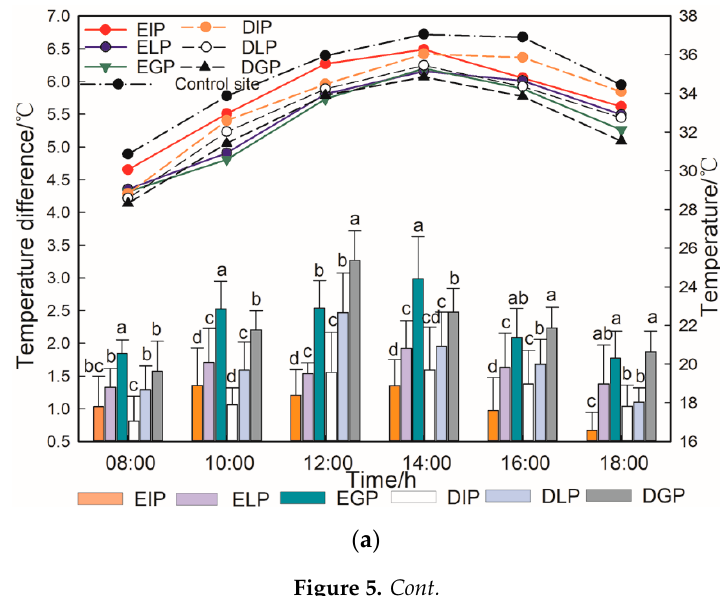
Figure 4. Diurnal variations of air temperature and relative humidity during the experimental